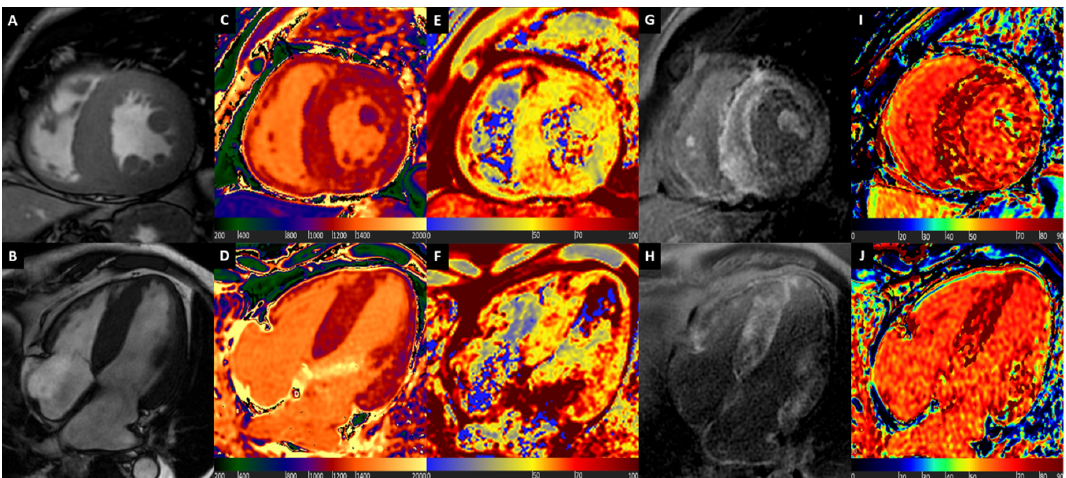
Figure 4. ATTR Cardiac Amyloidosis. Basal short axis view (Box A ) and 4-chamber long axis view (Box B ) balanced steady state free precession images showing diffuse myocardial hypertrophy and reduced longitudinal systolic function, mostly at basal and mid segments. Native T1 mapping shows diffuse marked increase of T1 values, with granular appearance (Boxes C and D ). Myocardial oedema detected by T2 mapping (Boxes E and F ), at basal segments. Late gadolinium enhancement (LGE) images show abnormal gadolinium kinetics, coupled with almost transmural enhancement at basal septum, and diffuse subendocardial enhancement at other segments (Boxes G and H ). Diffuse severe ECV expansion is noted, up to more than 80% at septal level (Boxes I and J ).